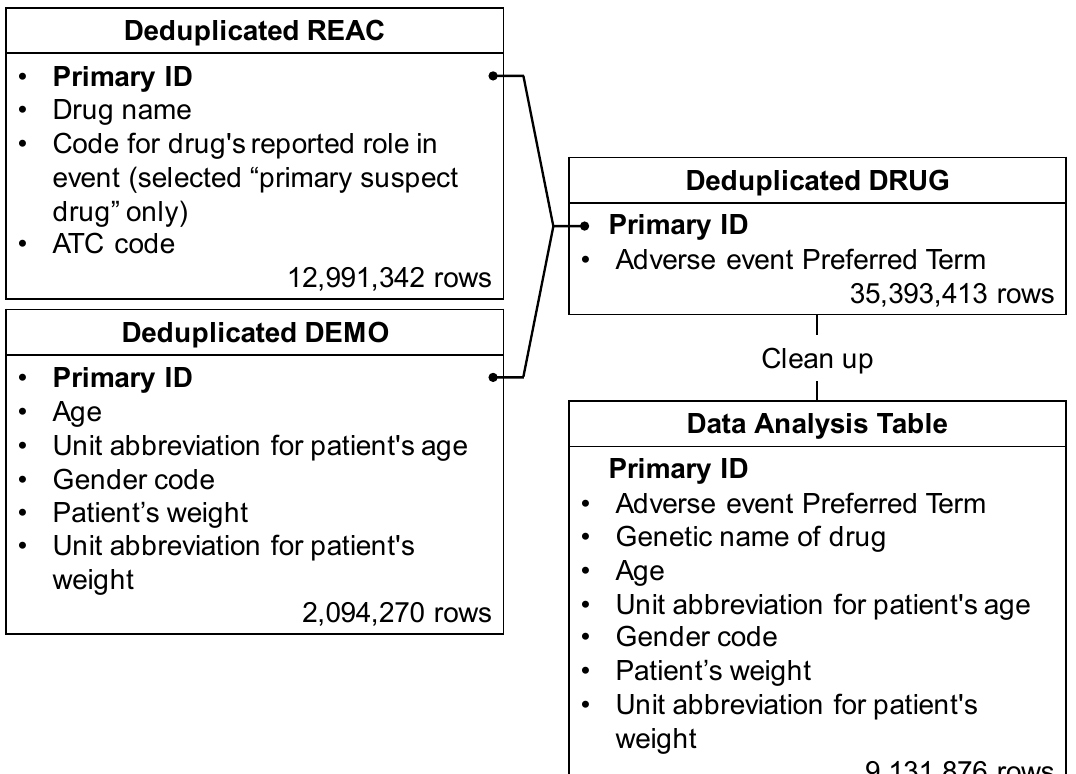
Figure 1. Flow chart for the construction of the data analysis table. The REAC table was classified into three categories: “suspected medicine,” “concomitant medicine,” and “interaction medicine.” We extracted only “primary suspect drug” information relevant to these categories from the REAC table. Duplicate data were then removed from the REAC, DEMO, and DRUG tables. Based on the combined table, only “suspected medicine” information was used to assess the risk of diarrhea. Available information on “suspected medicine,” “concomitant medicine,” and “interaction medicine” was used for the time-of-onset analysis. Each table was combined, cleaned up, and then used as the data analysis table.